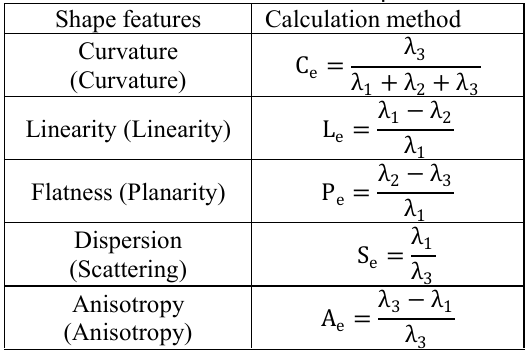
Table 1 Calculation methods for shape features Shape